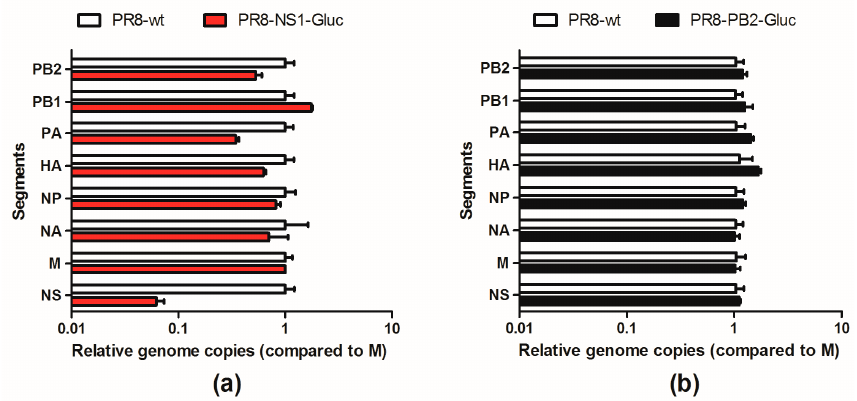
Figure 3. vRNA compositions of two reporter IAVs. MDCK derived PR8-NS1-Gluc ( a ) or PR8-PB2-Gluc ( b ) were extracted for vRNAs. The composition of vRNAs were examined by qPCR, and presented as the ratios of each vRNA segments versus M. The standard deviations were calculated based on three replicates.